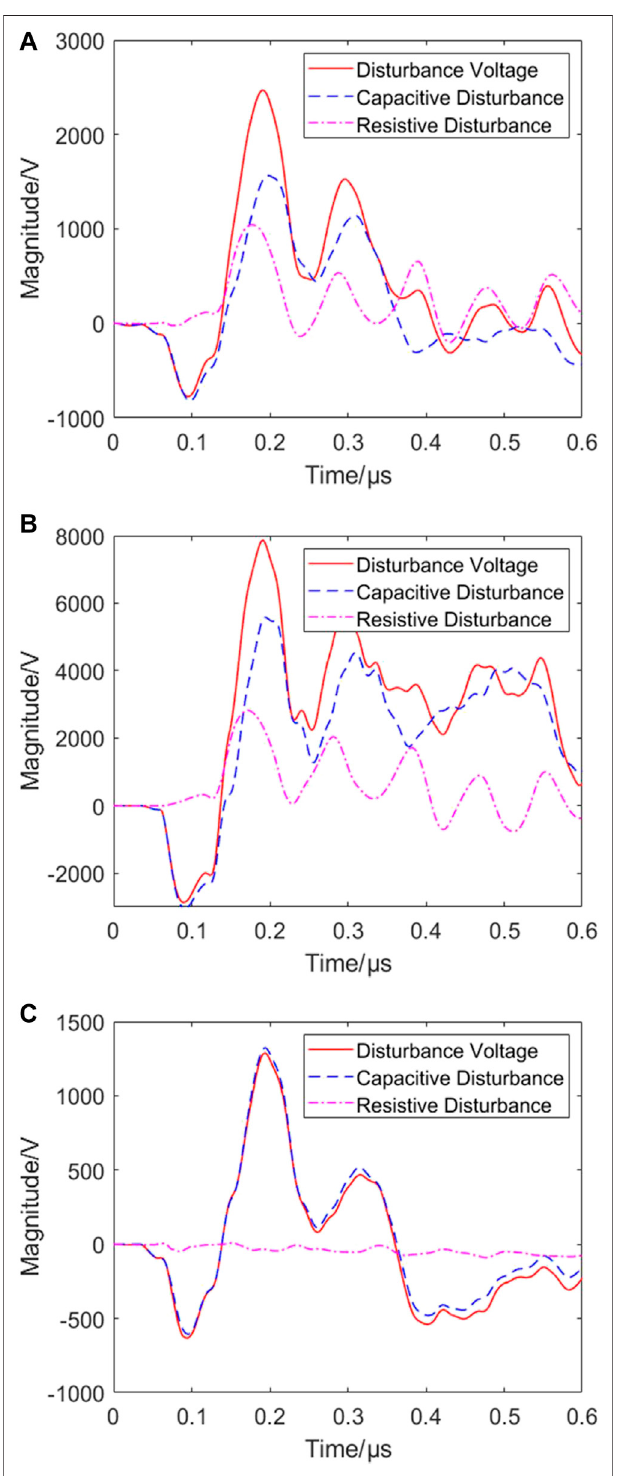
FIGURE 11 | Conducted disturbance voltage of secondary cable. (A) Two ends grounding. (B) Grounding of GIS side. (C) Grounding of control cabinet side.